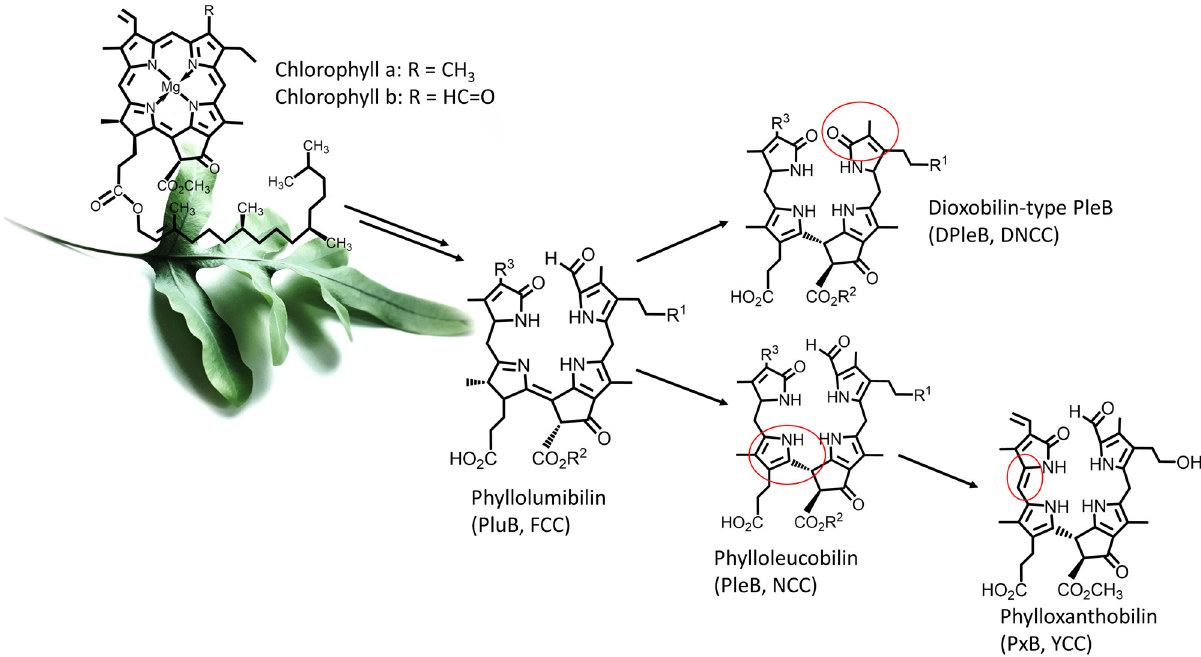
Figure 1: Outline of chlorophyll degradation in higher plants, depicting phyllobilins investigated for their anti - oxidative and immunomo - dulatory properties [ 4 ] . Chlorophylls are degraded via chlorophyll a to a fl uorescent chlorophyll catabolite intermediate ( PluB, FCC ) , from which di ff erent routes proceed. One route leads to colorless phylloleucobilins ( PleBs, non - fl uorescent colorless chlorophyll catabolites [ NCCs ]) and yellow phylloxanthobilins ( PxBs, YCCs ) . Another branch produces dioxobilin - type Plebs ( DPleBs, DNCC ) . Both routes are known to proceed further, and additional branches are known to exist [ 5 ] . Structural di ff erences between precursor and next catabolite are highlighted by a red